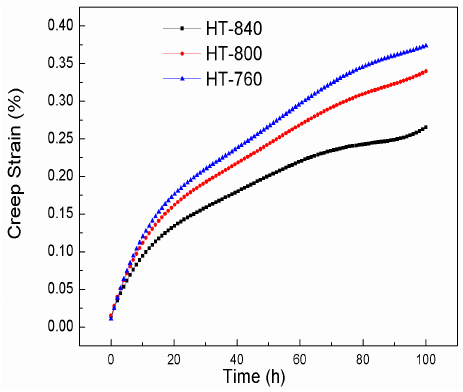
Figure 9. Creep curves at the stress of 150 MPa and temperature of 650 °C.